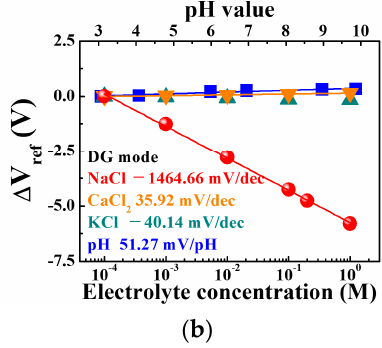
Figure 9. Sensitivity of the sodium ion sensor based on a SiNW channel DG FET with sodium-selective membrane EG in various buffer solutions during the ( a ) SG mode and ( b ) DG mode operations.